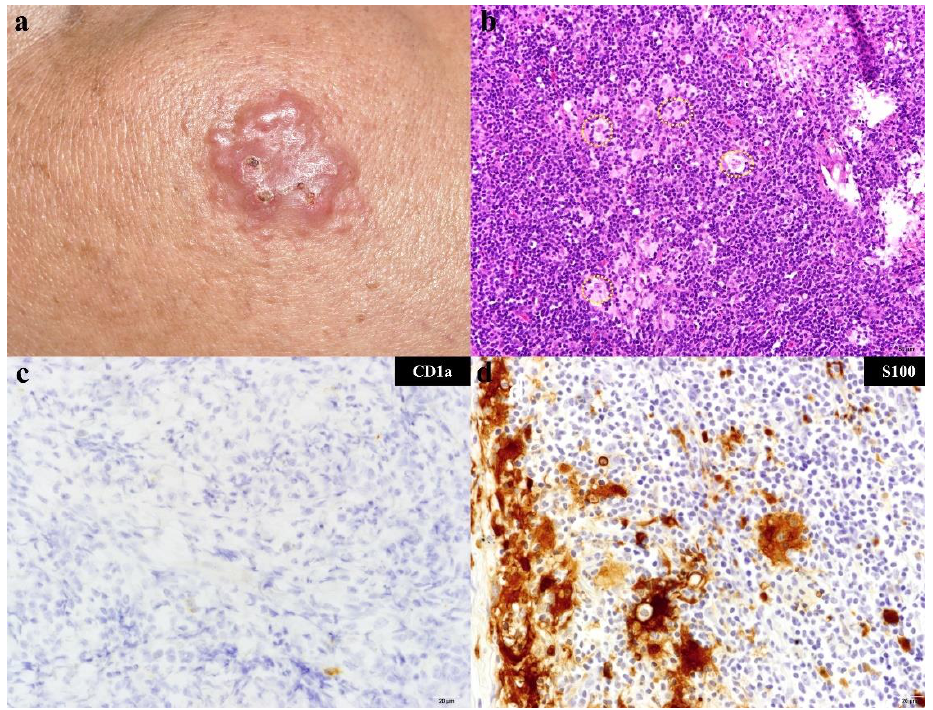
Figure 1. Clinical and pathologic features of the case 4. ( a ) The patient was a 46-year-old man who presented with a mild itchy erythematous nodular plaque on the right cheek for 5 months; ( b ) In the skin biopsy specimen, aggregates of Rosai–Dorfman (RD) cells with pale staining cytoplasm, large nuclei, and prominent nucleoli were seen in a lymphoid-rich background. Emperipolesis was noted (yellow circle, 200×). Scale bar = 50 μM; ( c ) Immunohistochemistry of CD1a was negative (400×). Scale bar = 20 μM; ( d ) S100 staining was positive in RD cells (400×). Scale bar = 20 μM.